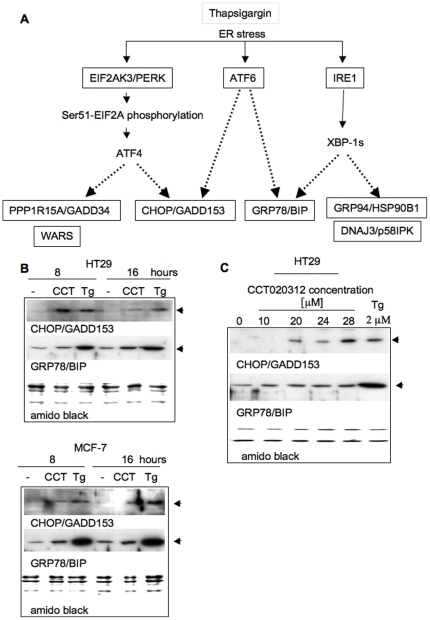
CCT020312 does not induce full ER stress signalling.
A) Schematic of unfolded protein response signalling. Response biomarkers are indicated. B) UPR response marker expression in HT29 colon and MCF7 breast cancer cells. Cells were treated with CCT020312 (CCT, 10 µM) or thapsigargin (Tg, 2 µM) as indicated and analysed by immunoblotting for CHOP/GADD153 and GRP78/BIP. C) UPR response marker expression following CCT020312 dose escalation. HT29 cells were treated for 16 h. Lysates were analyzed as in B.